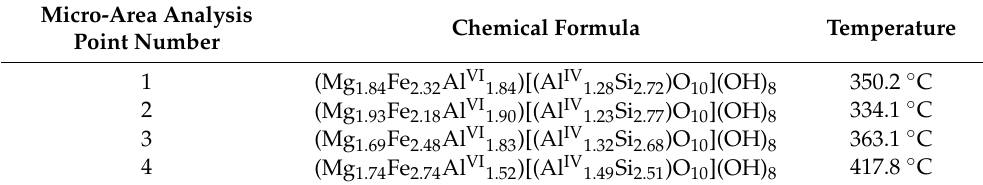
Table 7. Chlorite mineral thermometer